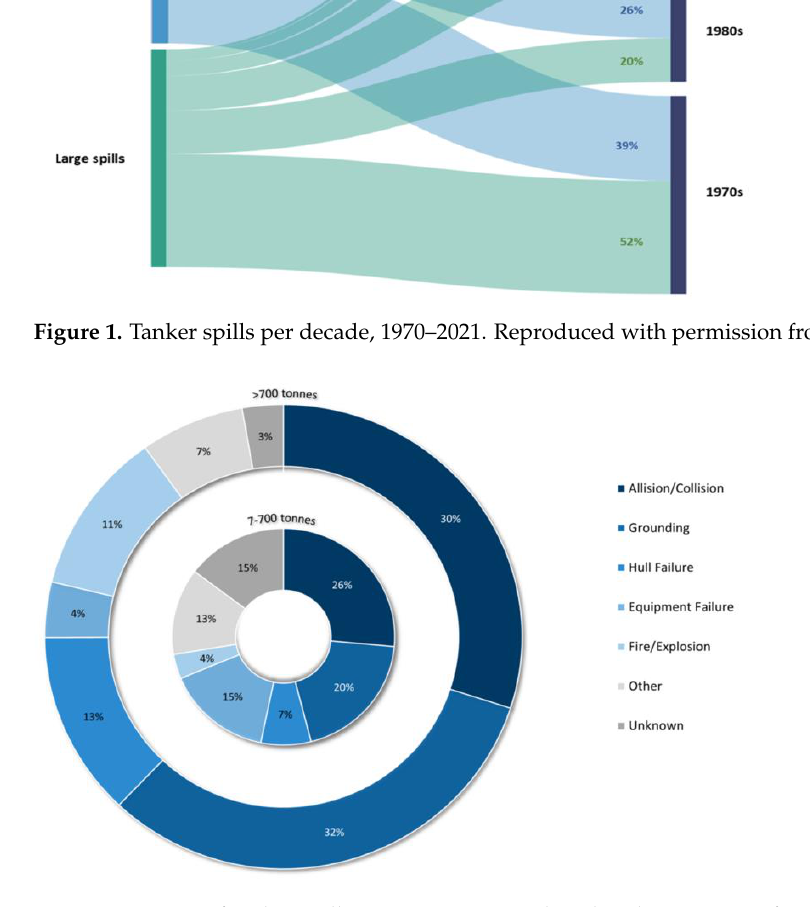
Figure 2 . Causes of tanker spills, 1970 – 2021. Reproduced with permission from ITOPF, 2022 [7]. Figure 2. Causes of tanker spills, 1970–2021. Reproduced with permission from ITOPF, 2022